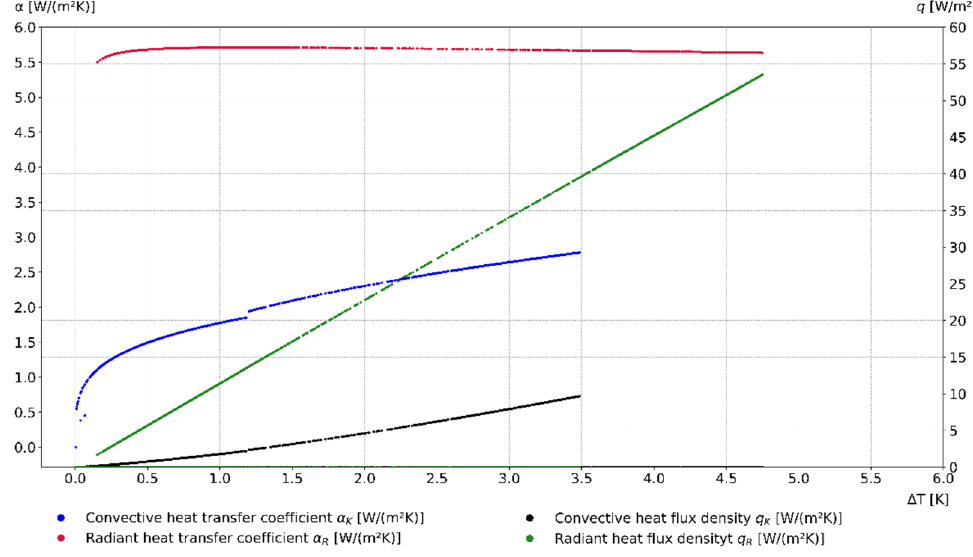
Figure 12. Quasi-steady-state conditions—activation time and work hours.